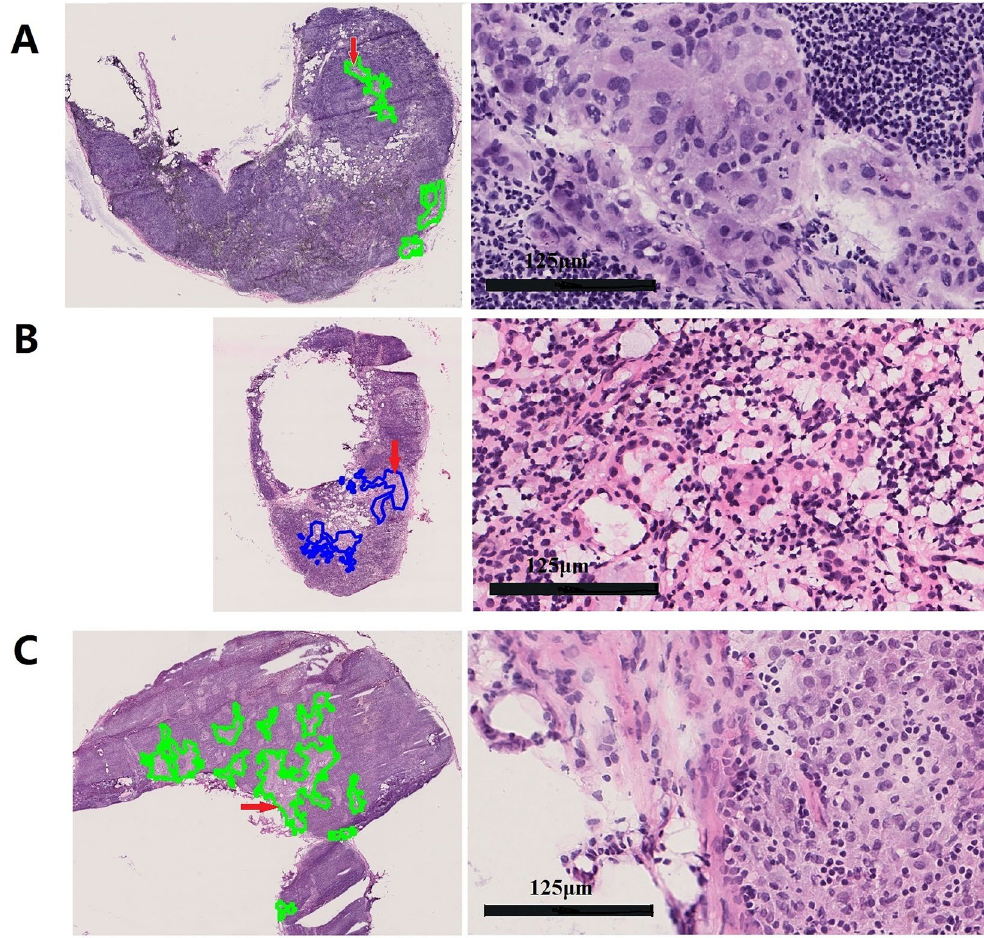
Figure 2. Pathology experts’ analysis of the misclassification errors for the test sets. A – C , Randomly selected examples of incorrect classification results for the test set. Examples of true positive, false negative and false positive classifications are shown for every WSI, with the figures to the right representing the enlarged areas indicated by the red arrows. ( A ) The true positive area represents an incorrect taken FS during the process of section scanning. ( B ) The false-negative area is the result of cancer tissue growth intermingled with lymphocytes, showing a linear structure that does not gather together. ( C ) The false-positive case, in which the model identifies the section as the medullary